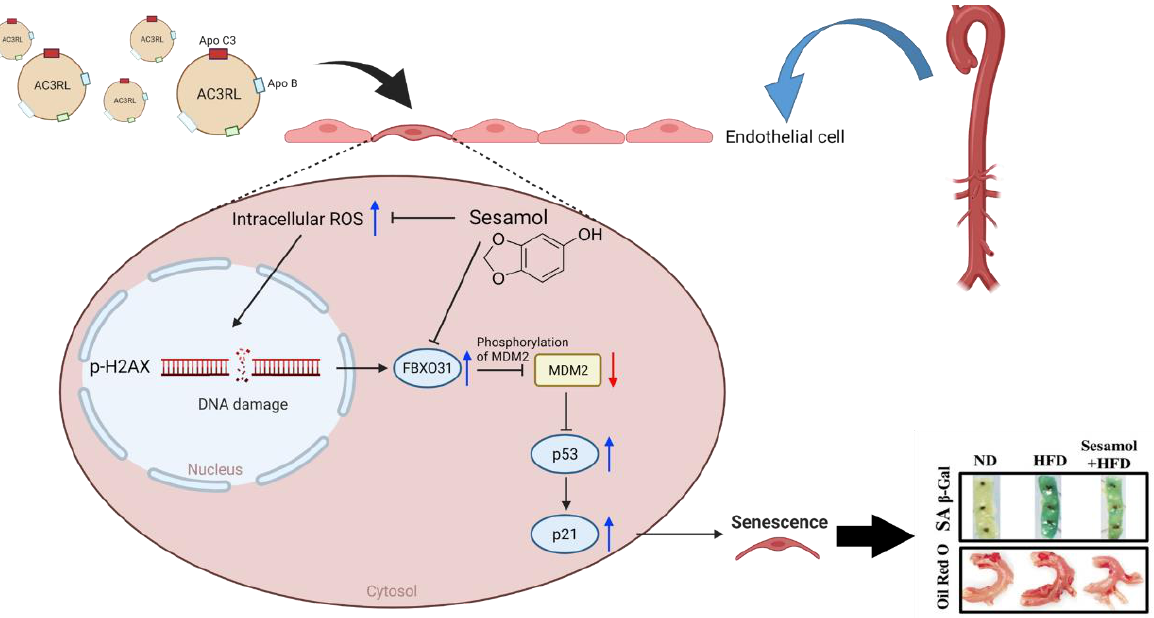
Figure 7. Scheme of AC3RL-induced cell senescence and how sesamol inhibited it. FBXO31 is a subunit of the RING finger SCF4 (SKP1-Cullin 1-F-box protein) E3 ubiqui- tin ligases complex [29] and is involved in the regulation of DNA damage response-related proteins [30]. The FBXO31-mediated loss of MDM2 leads to elevated p53 levels,